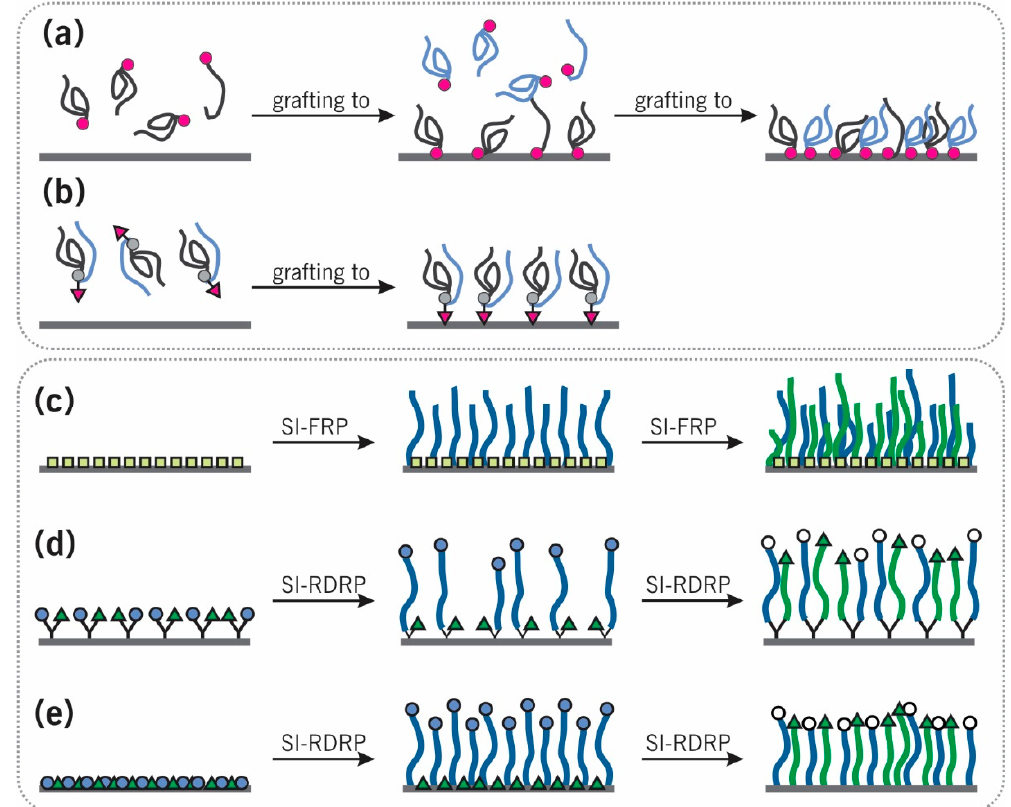
Figure 2. Schematic illustration of different synthetic routes. ( a ) Step-wise “grafting to” of individual homopolymers, ( b ) “grafting to” of Y-shaped diblock copolymers, ( c ) step-wise “grafting from” via surface-initiated free-radical polymerization (SI-FRP) using non-selective initiators, ( d ) “grafting from” via surface-initiated reversible-deactivation radical polymerization (SI-RDRP) using two dis- parate co-deposited initiators, and ( e ) “grafting from” via SI-RDRP using Y-shaped bifunctional ini- tiators.